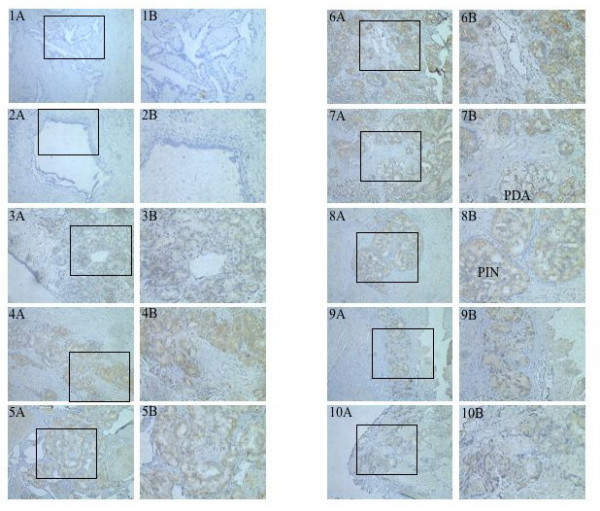
Immunohistochemical staining of EphB4 in several foci of a single prostate cancer sample. The expression of EphB4 a different foci in a single patient sample was compared by immunohistochemistry. Images from 10× magnification (A) and a region from this (as indicated by the box) at 20× magnification (B) are shown for 2 regions of normal prostate duct (1 and 2) and 8 regions with disease (3–10) from this single sample. A comparable level of EphB4 staining was seen in regions of high grade PIN (eg. focus 8 indicated PIN) and regions of poorly differentiated adenocarcinoma (eg. focus 7 indicated PDA). Regions of well-differentiated (eg focus 3) and moderately differentiated (eg focus 10) also show comparable staining.